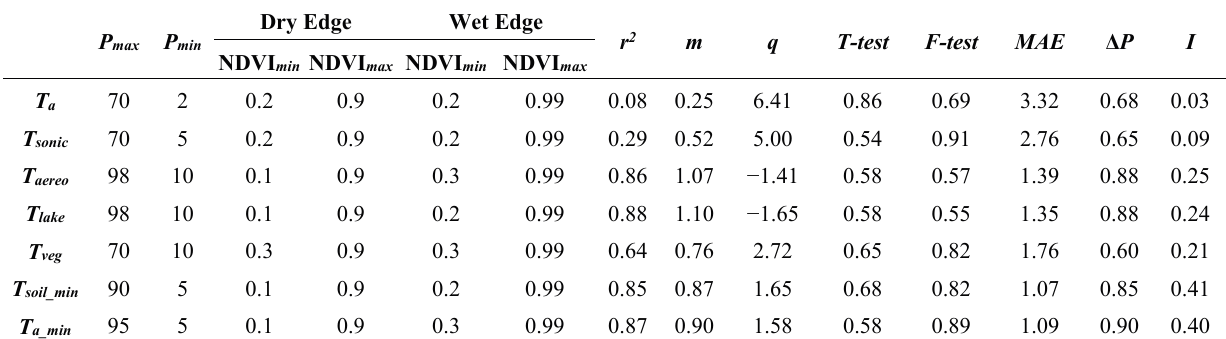
Table 2. Best-fit parameters for given